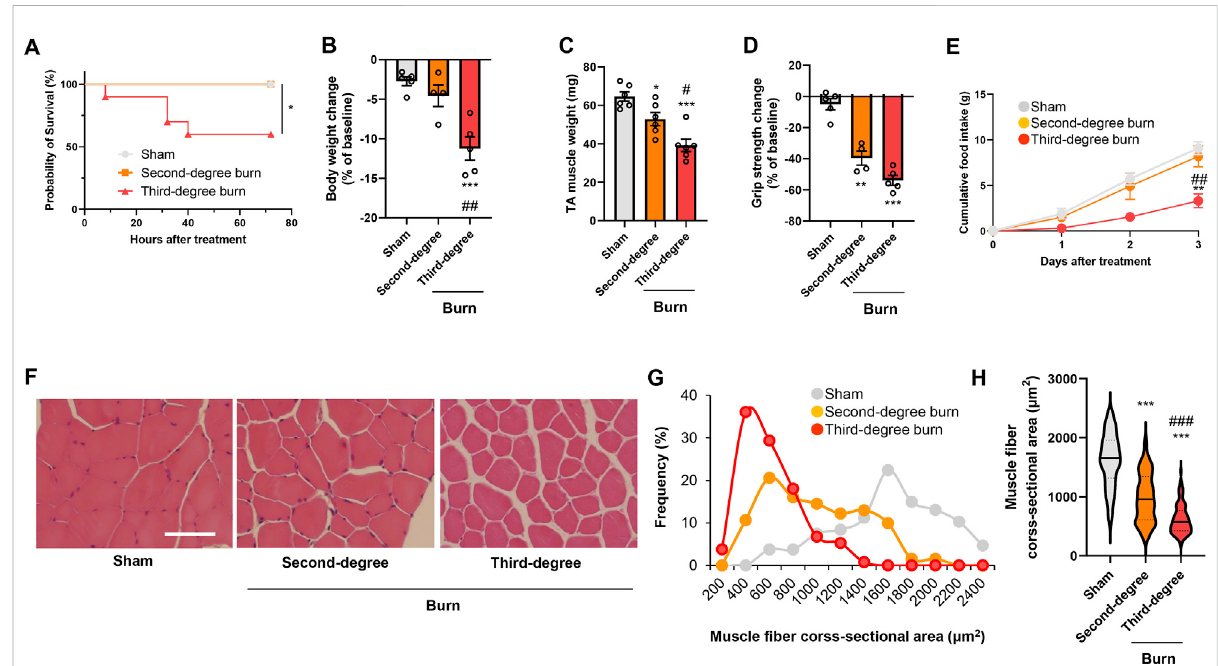
FIGURE 1 Thermalburninjuryinducesmuscleatrophyandweaknessinmicebyaseveritydependentmechanism.Second-degree,third-degree,orsham burns wereadministered to wild-type C57BL/6 mice (12 – 16-week-old male mice). (A) Cumulative survival after burn or sham burninjury. N = 5 – 10/ group. * p < 0.05 by log rank test. After 3 days of burn or sham-burn injury, mice body weight (B) , TA muscle weight (C) , and grip strength (D) were assessed. Food intake (E) was measured every 24 h up to 72 h. N = 4 – 6/group. Representative images of H&E-stained TA muscle sections (F) and quanti fi cation of the distribution (G) and violin plot (H) of cross-sectional areas of TA muscle fi bers 3 days after thermal burn injury. The continuous lines and dotted lines within the violin plot indicate the median and quartiles, respectively. The cross-sectional area of TA muscle fi bers was measured. Scale bar, 50 µm. N = 106 – 133/group. For all panels, data are presented as the mean ± s.e.m. *** p < 0.001, ** p < 0.01, * p < 0.05